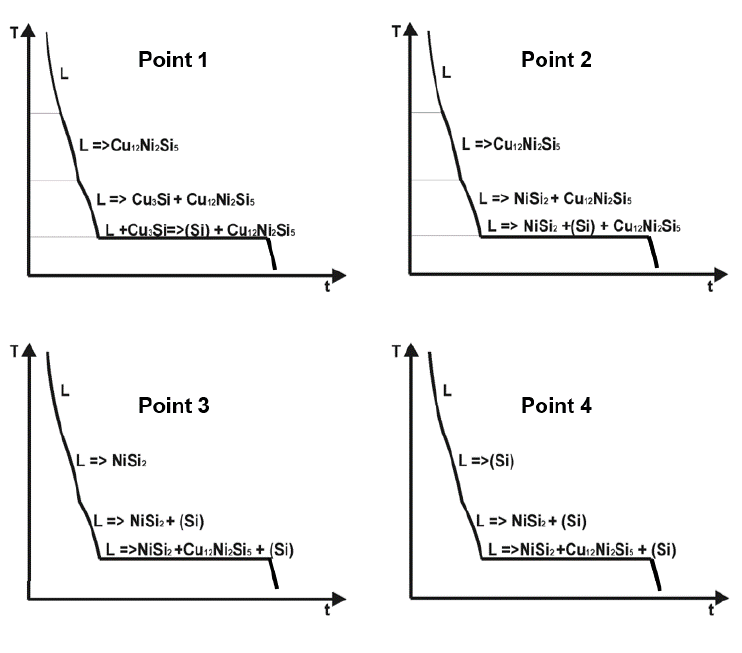
Figure 3. Qualitative cooling curves of points 1 to 4 from the ternary system